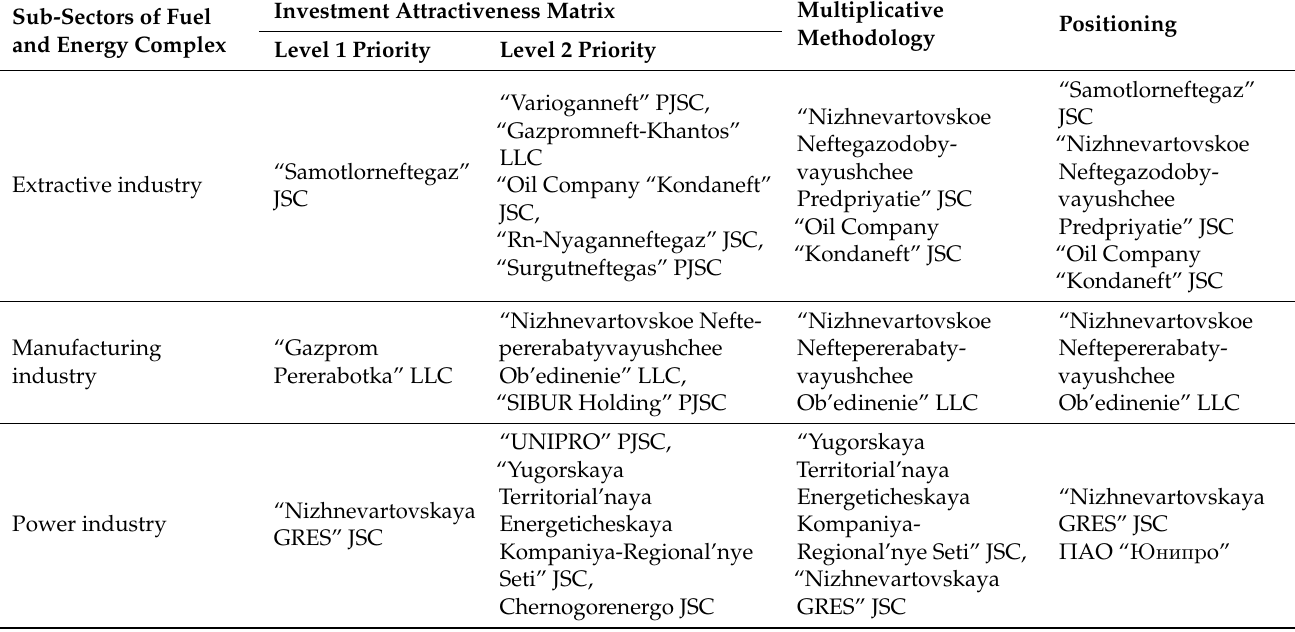
Table 5. Comprehensive study: priority industrial enterprises for investment.